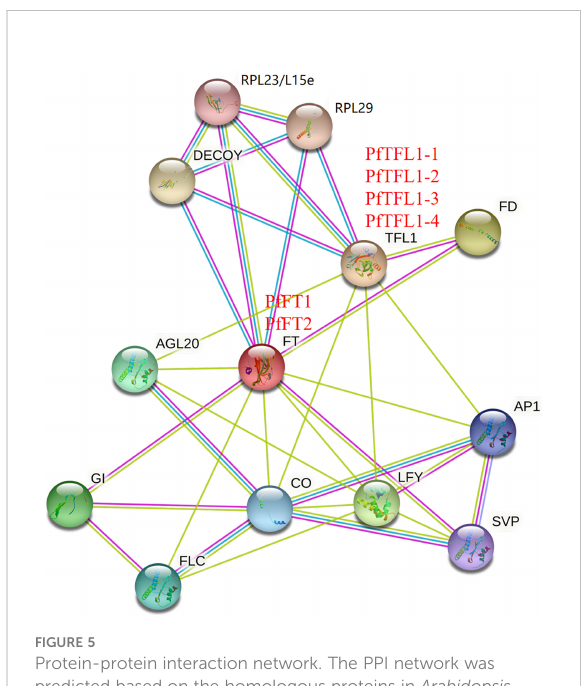
FIGURE 5 Protein-protein interaction network. The PPI network was predicted based on the homologous proteins in Arabidopsis . RPL23/L15e, Ribosomal protein L23/L15e family protein; RPL29, Ribosomal protein L29 family protein; DECOY, DECOY; FD, FLOWERING LOCUS D; TFL1, TERMINAL FLOWER 1; FT, FLOWERING LOCUS T; AGL20, AGAMOUS-LIKE 20; AP1, APETALA1; GI, GIGANTEA; CO, CONSTANS; LFY, LEAFY; SVP, SHORT VEGETATIVE PHASE; FLC, FLOWERING LOCUS